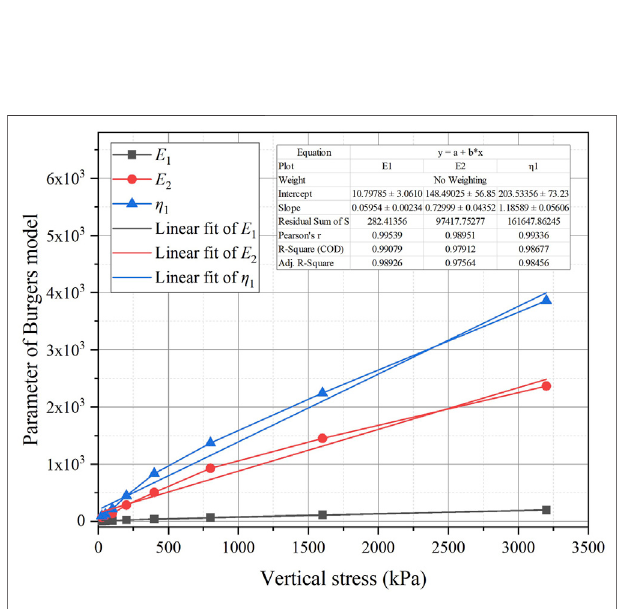
FIGURE 6 | Fitting parameters under different vertical stresses. (A) is exponential, (B) is Burgers.